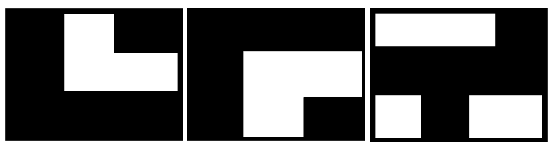
Figure 9. Example Geometric Patterns used for identification and tracking